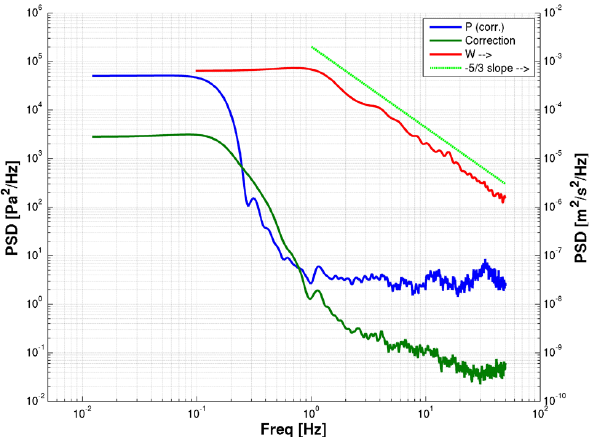
Fig. 13. Power spectral density [variance/frequency unit] versus fre- quency [Hz] for period of attack angle change at 7000m altitude. Left axis: corrected static pressure [Pa], and pressure correction [Pa]. Right axis: vertical wind component [m s − 1 ] and inertial sub- range − 5/3 slope.